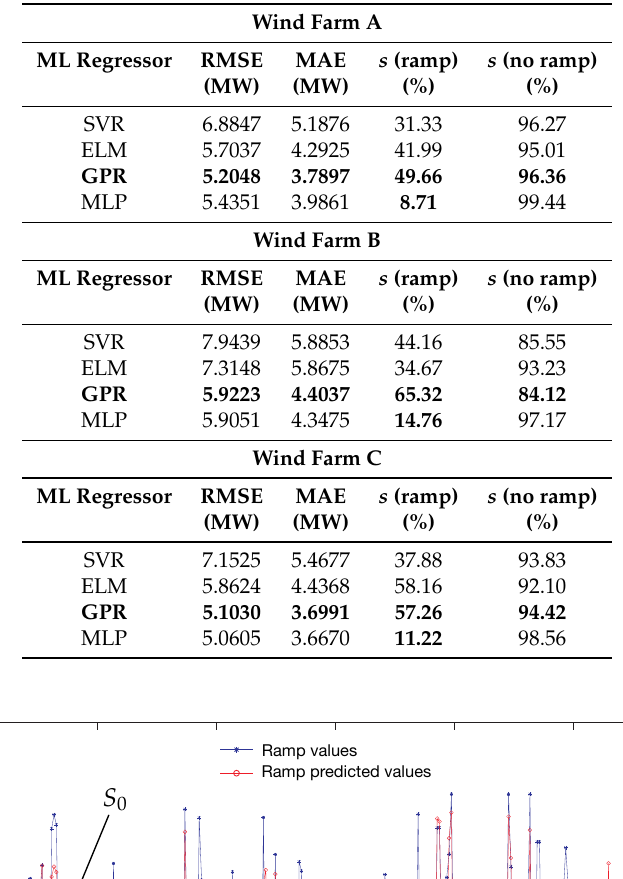
Table 5. Results (in terms of RMSE, MAE and sensitivity) corresponding to the estimation of the ramp function S 2 t ( Equation (2) ) obtained by the proposed approach as a function of the ML regressors explored (SVR, ELM, GPR, and MLP), for Wind Farms “A”, “B” and “C”, respectively.